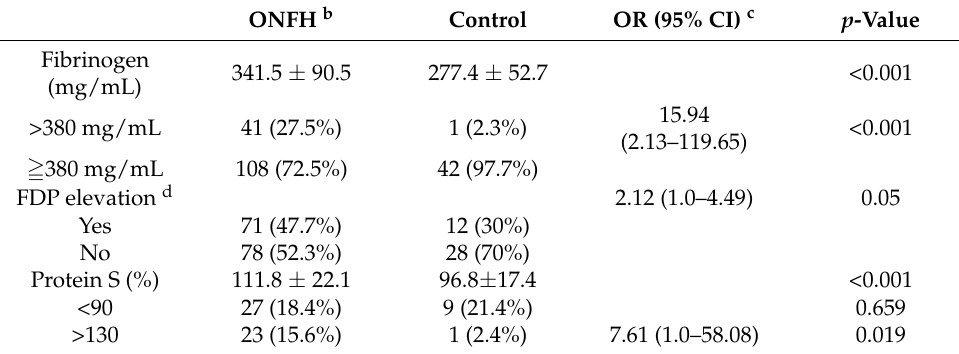
Table 2. Association of Coagulopathy with NOS a polymorphism and